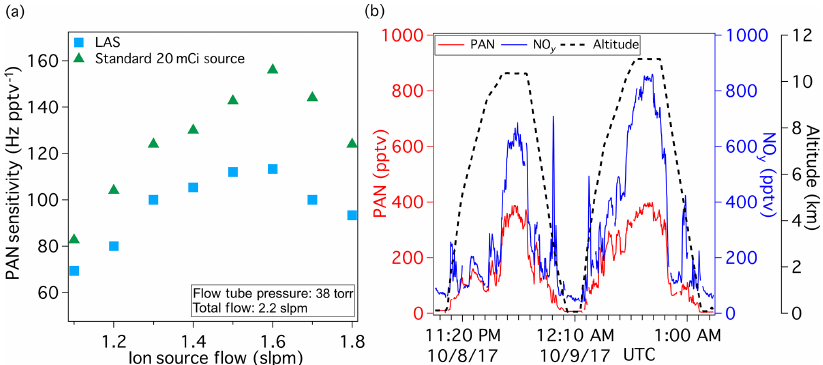
Figure 5. The performance of the LAS for PAN measurement during the ATom field mission. Both sources are less than 1 month old. (a) The sensitivity comparison of the LAS and a standard source for the ATom instrument conditions. (b) DC-8 flight data obtained during intersects of a Southern Hemisphere plume. PAN (red trace) and NO y (blue trace) are plotted along with the pressure altitudes (black